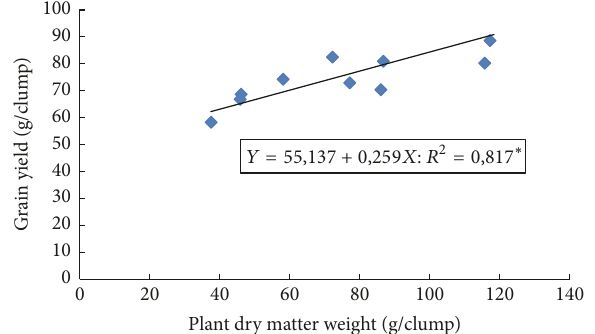
Figure 3: Relationship pattern between plant dry matter weight and grain yield. ∗ 𝑅 2 = 0, 817 is the value of the goodness of fit between grain yield per clump and dry weight of plant per clump.